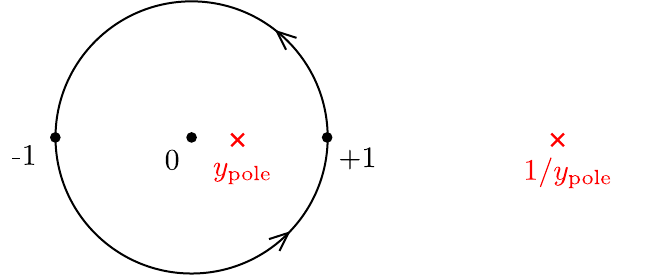
Figure 2: Positions of poles of the y -integral in (3.59). The integrand has two poles: for s (cid:28) 1, one of them is inside the integration contour while the other is